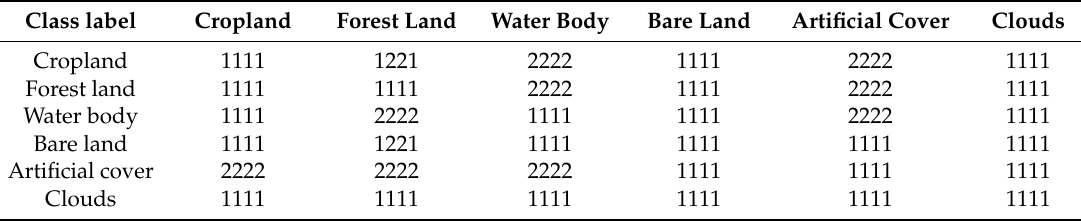
Table 3. Four-digit codes for Level-2 classes.